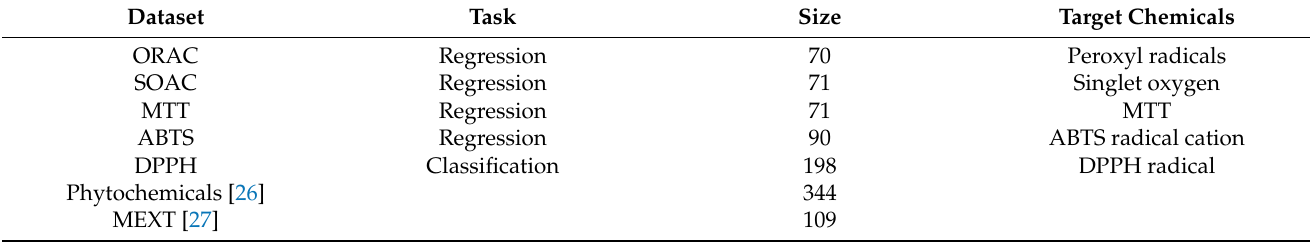
Table 1. Datasets used in this study. Five datasets were prepared for each task and were used for both supervised learning and dimension reduction. The remaining two without tasks were used only for dimension reduction. MEXT is a dataset consisting of food ingredients listed in the document published by the Japanese Ministry of Education, Culture, Sports, Science, and